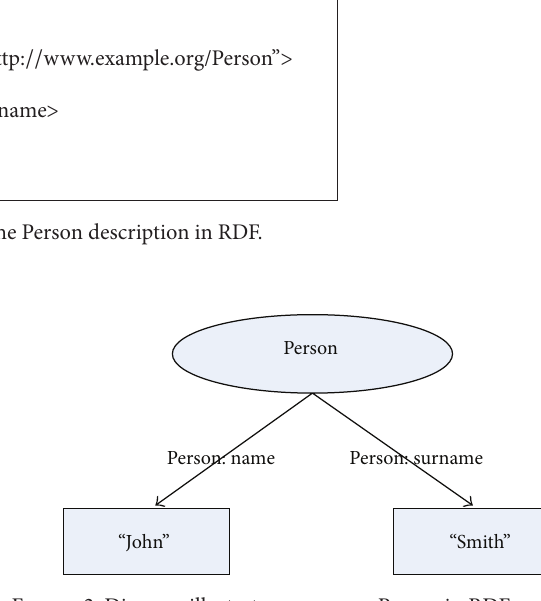
Figure 2: Diagram illustrates a resource Person in RDF graph. The resource consists of two atomic attributes “John” and “Smith” that are assigned to it with relations “PERSON: Name” and “PERSON: Surname”. In other words, the name of the person is “John” and the surname of the same person is “Smith.” Note that the word “PERSON:” denotes a location (URI), where a name space containing the description of semantics for this relation is